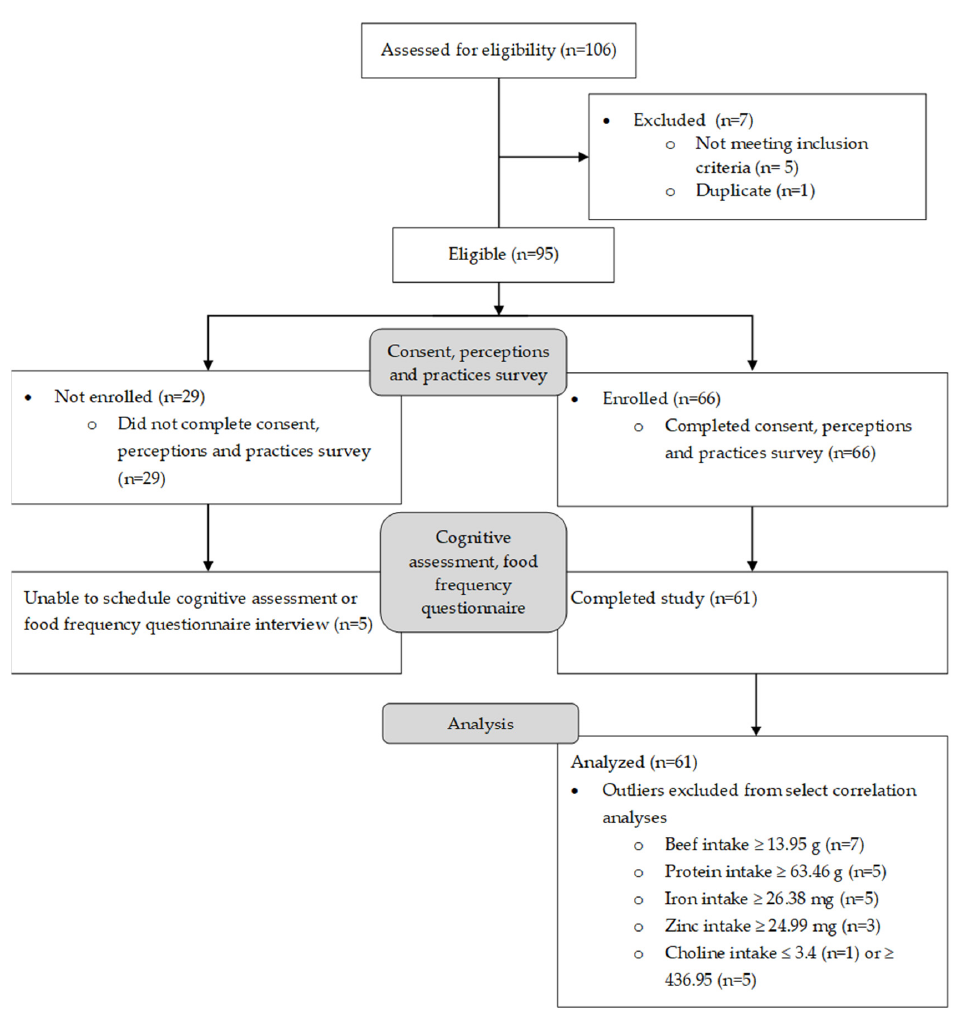
Figure 1. Consort diagram of eligible, enrolled, and analyzed subjects.